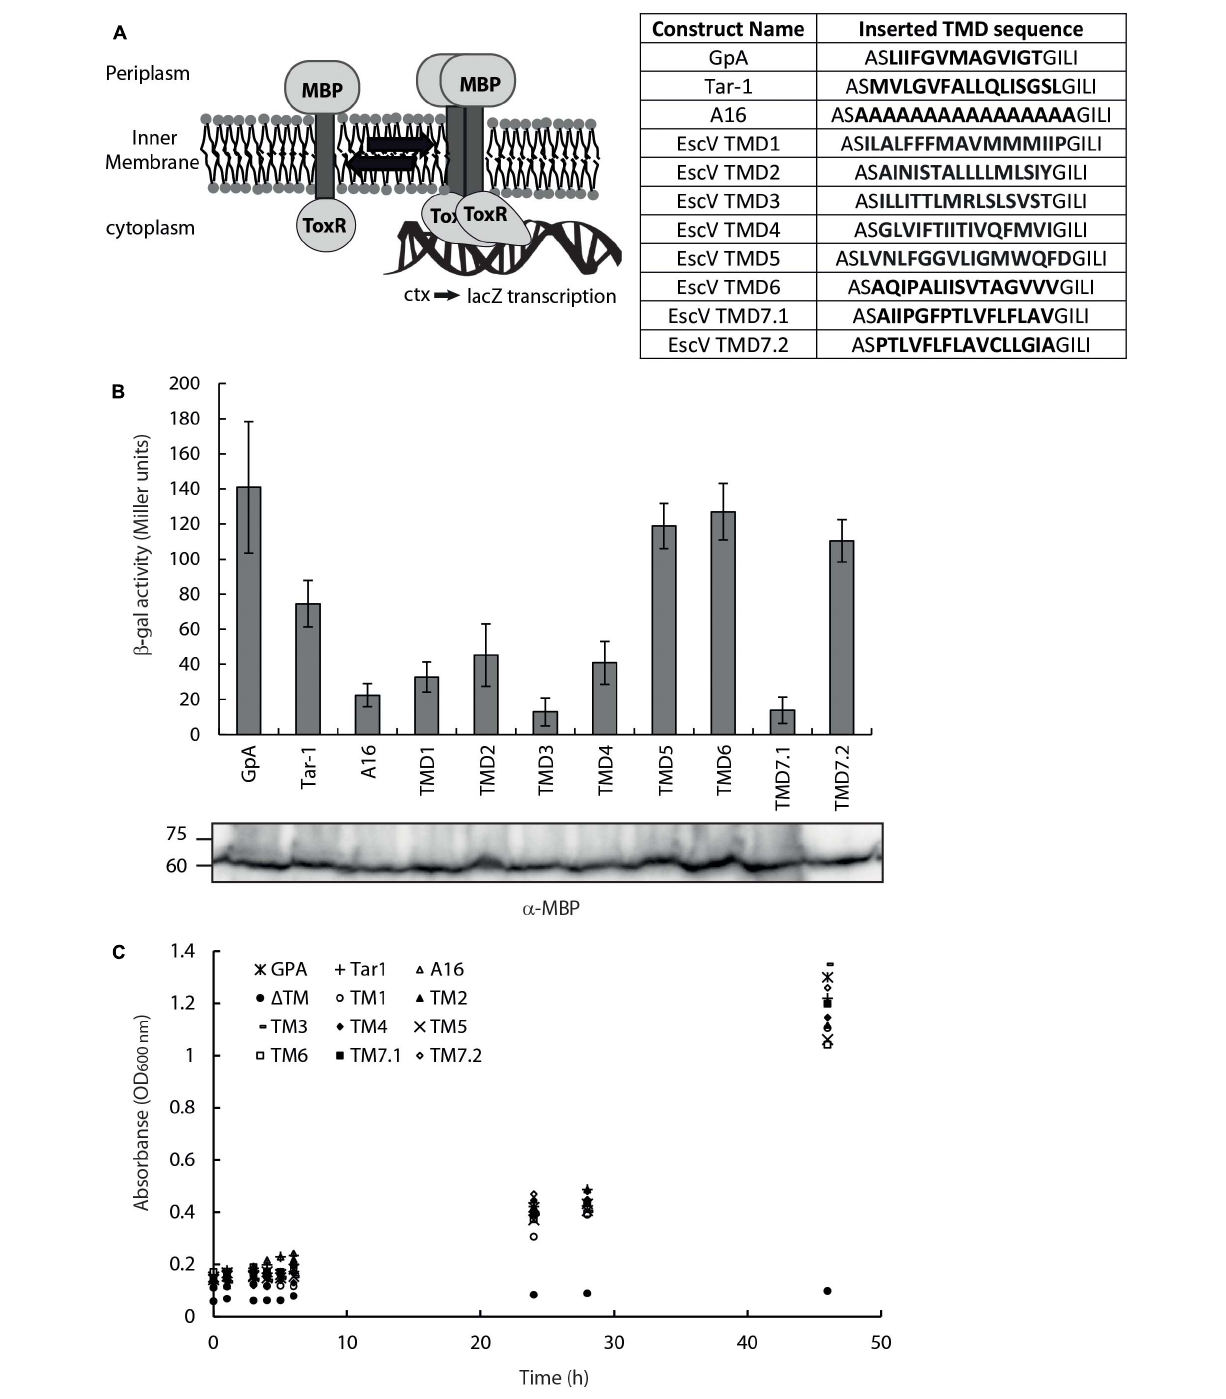
FIGURE 2 | EscV TMD self-oligomerization activity. (A) Schematic illustration of a ToxR assembly system. TMD–TMD interaction promotes oligomerization of the transcription activator ToxR, which then can bind (in its oligomeric form) the ctx promoter and transcribe the reporter gene, lacZ . The TMD sequences inserted between the ToxR and the MBP are presented. (B) The LacZ activities of FHK12 bacterial strains expressing the ToxR-TMD-MBP chimeras of various EscV TMDs, GpA, Tar-1, and A16 TMDs. Bars represent the standard deviation of at least three independent experiments. The expression of ToxR-TMD-MBP chimera proteins containing the different TMD sequences was analyzed on SDS-PAGE and western blotting using an anti-MBP antibody and presented under each corresponding sample. (C) Growth curves of PD28 bacteria transformed with plasmids encoding ToxR-TMD-MBP chimera protein containing the GpA (*), Tar-1 (+), A16 ( (cid:77) ), EscV TMD1 ( ◦ ), TMD2 ( (cid:78) ), TMD3 (-), TMD4 ( (cid:117) ), TMD5 ( × ), TMD6 ( ), TMD7.1 ( (cid:4) ), TMD7.2 ( ♦ ) or in the absence of a TMD ( (cid:49) TM, • ). The bacteria were grown in a minimal medium containing maltose. All bacterial cultures showed similar growth curves, indicating proper membrane (cid:50)